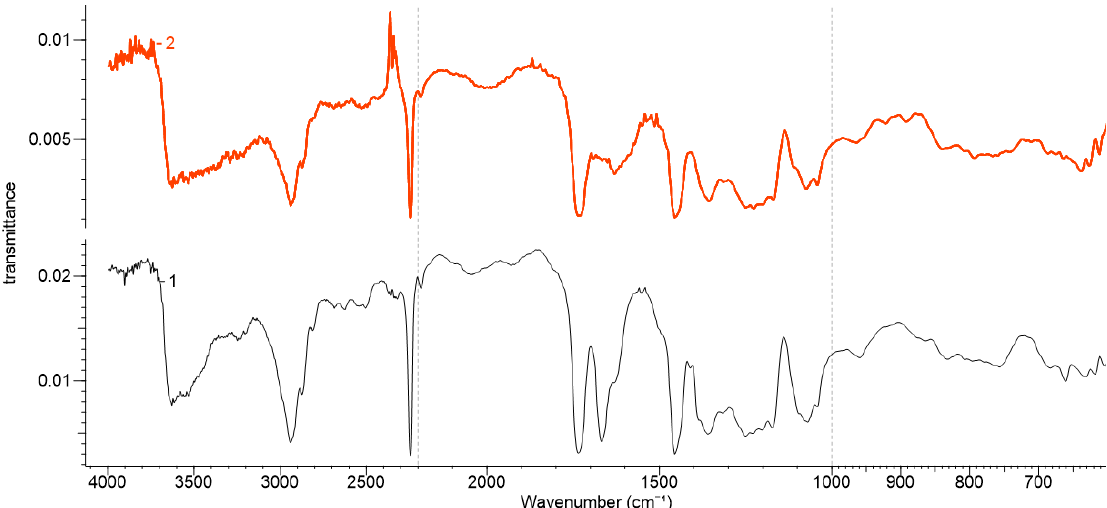
Figure 3. FTIR spectra of Dralon L: pristine ( 1 ) and ( 2 ) after functionalization.